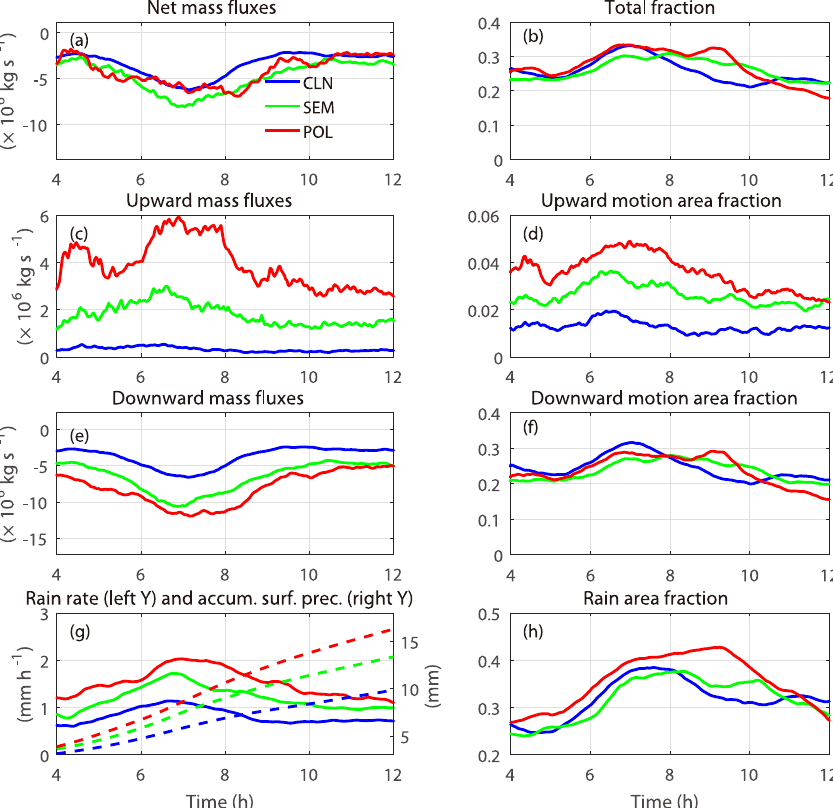
Figure 9. Time series of (a) net cloud mass fluxes and (b) area fraction over the entire cloudy area crossing the ZTL for clean (blue curve), semi-polluted (green curve), and polluted (red curve) experiments. Panels (c, d) and (e, f) are similar to panels (a, b) , but for upward ( V COG >0) and downward ( V COG <0) motion areas, respectively. Panel (g) is a time evolution of domain-averaged rain rate (solid lines) and accumulated surface rain (dashed lines). Panel (h) is a time evolution of the rainy area fraction at the